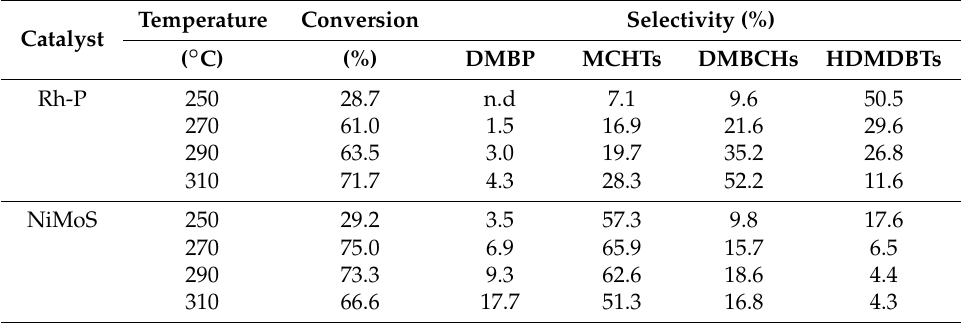
Figure 4. Effect of reaction temperature on activities of Rh-P and NiMoS catalysts for the HDS of 4,6-DMDBT at 4.0 MPa. Table 3. Product selectivity in the HDS of 4,6-DMDBT over Rh-P and NiMoS catalysts at 4.0 MPa. n.d: not